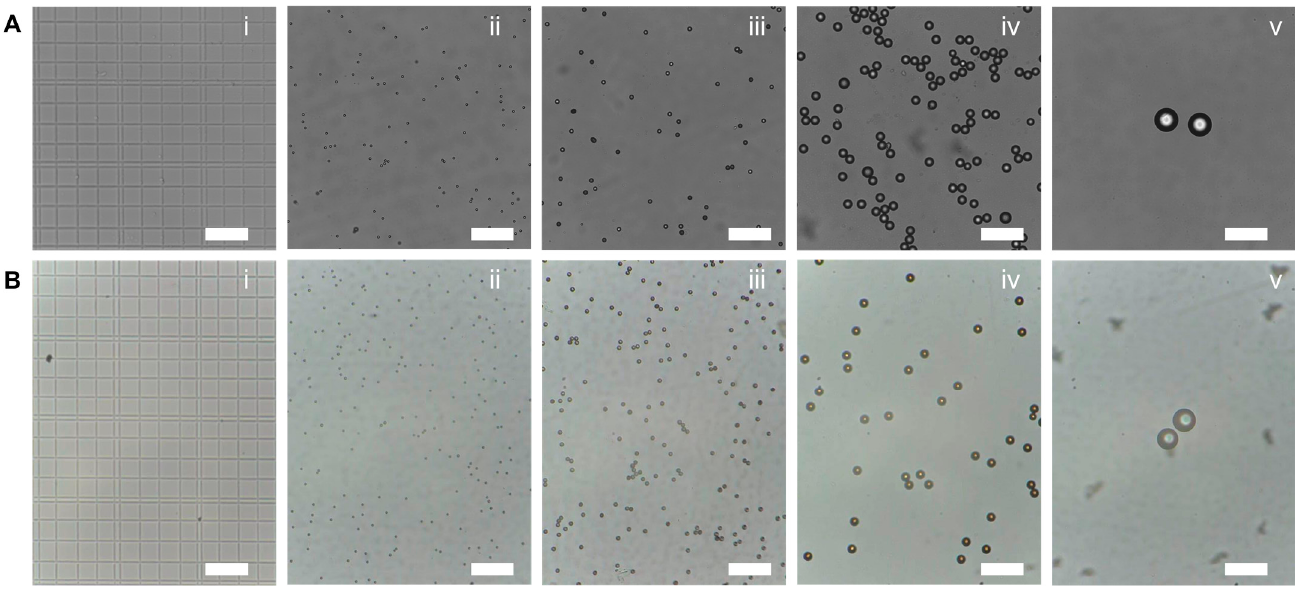
Figure 2. Performance of our portable microscopic device, with maximum FOV and minimum magnification, compared with commercial microscope. ( A ) Microscopic image of a commercial hemocytometer captured by Nikon microscope. ( B ) Microscopic image of a commercial hemocytometer captured by the portable microscopic device proposed in this work. From left to right, labeled with ( i – v ), stands for the microscopic image of a commercial hemocytometer, polystyrene particles with diameters of 5 μ m, 10 μ m, 20 μ m and 50 μ m, respectively. Scale bars are 100 μ m.